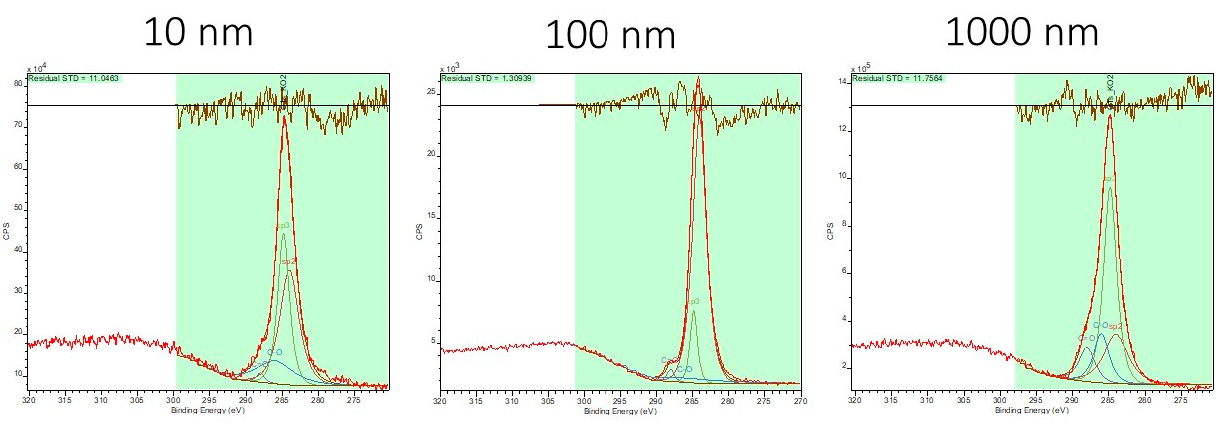
Figure 7. Exemplary XPS peak deconvolution for the a-C:H layer thicknesses of 10, 100 and 1000 nm. The analysis was performed on the sp 2 , sp 3 , C-O and C=O fractions using CasaXPS software.